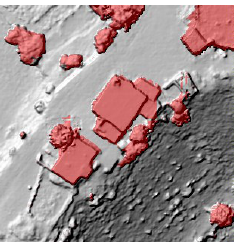
Figure 6. A combination of all four masks. The steep cliff side is left untouched while the buildings and trees are masked out.